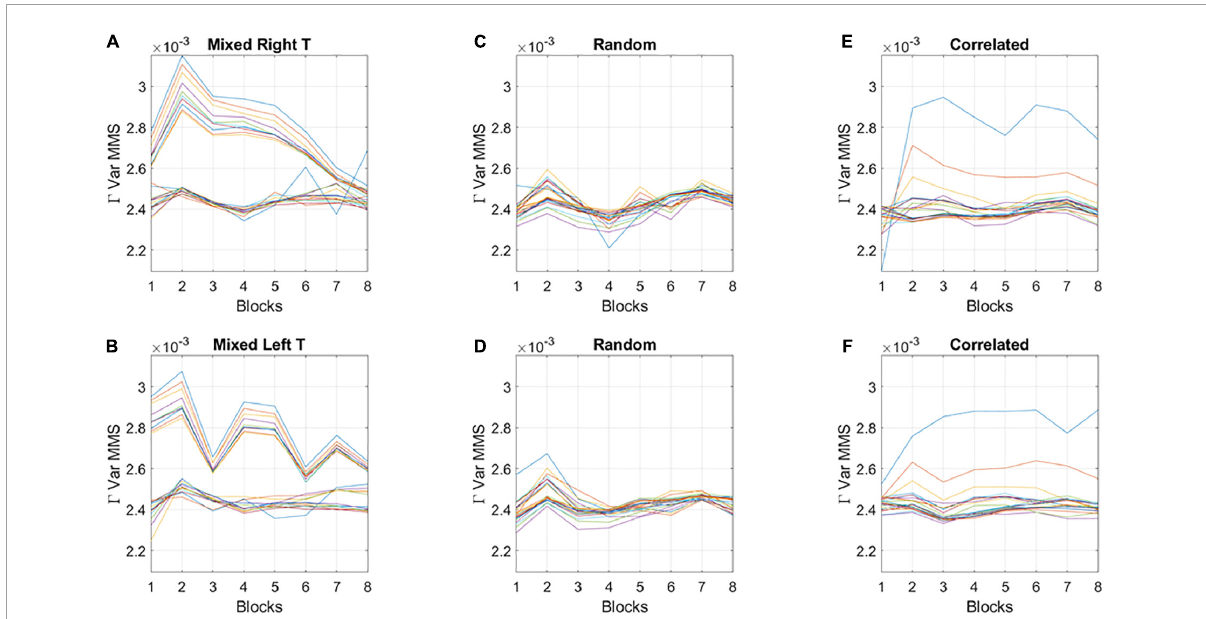
FIGURE6 Broad- and narrow-variance groups according to the empirically estimated Gamma variance parameter block by block. (A,B) Two subgroups in the mixed group are revealed for right- and left-oriented targets (each curve represents the trajectory of a participant within the group). The subgroup with lower variance and narrower bandwidth of values throughout the experimental session separate from those in the subgroup with high variance and broader bandwidth of values. However, both subgroups converge to similar variance levels toward the 8th block of learning. Target types show different trajectories but similar convergence trend. (C,D) Random group shows similar levels of variance and stable learning throughout the experimental session, as does the correlated group (E,F) (with two